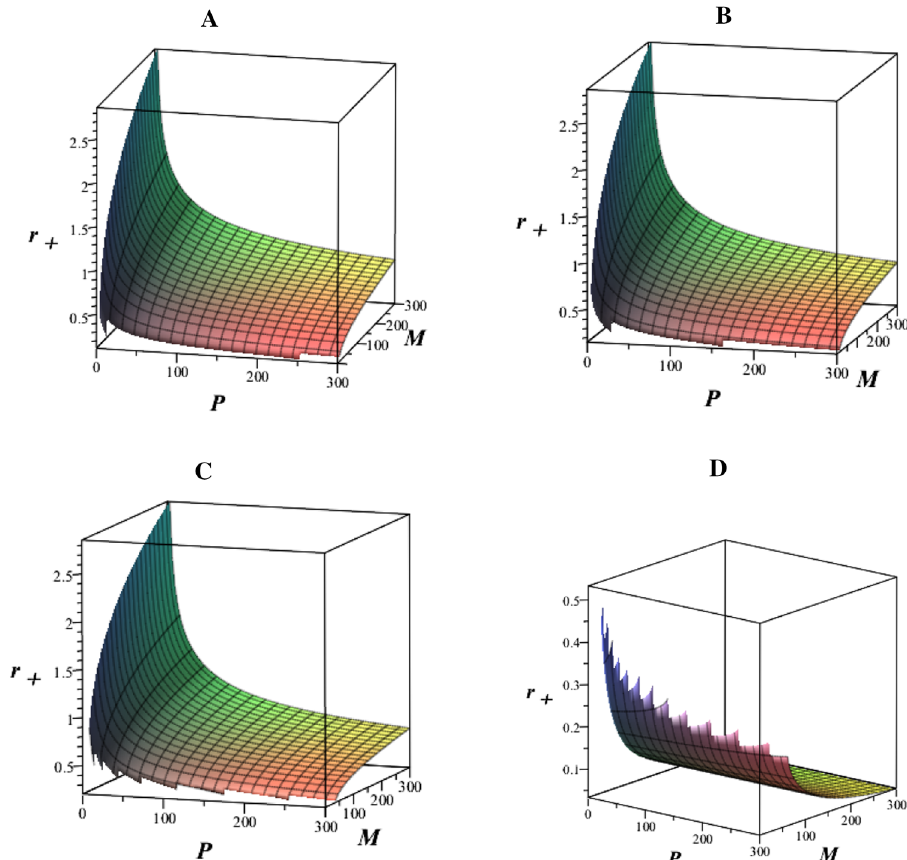
Fig. 8 Event horizon of dynamic phantom AdS BH for a 2 = 2. A : e 2 = 0 .